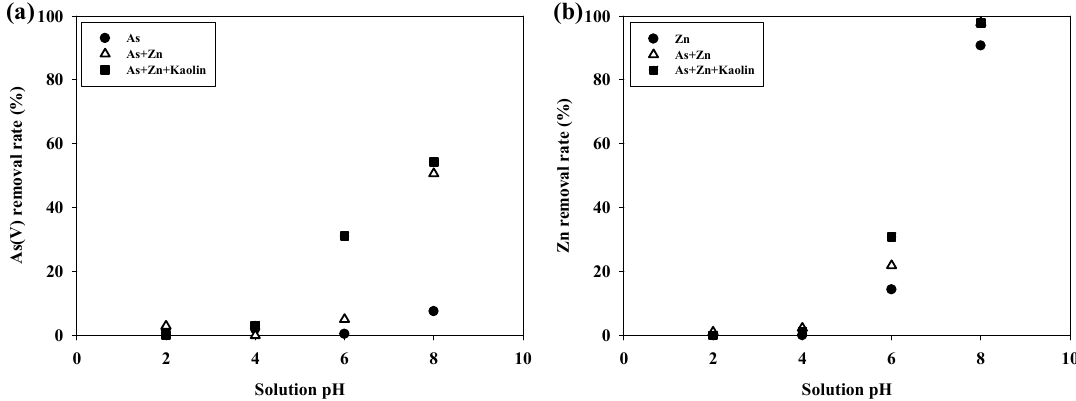
Figure 2. (a) As(V) and (b) Zn(II) removal according to solution pH using the ceramic membrane. Figure 2. ( a ) As(V) and ( b ) Zn(II) removal according to solution pH using the ceramic membrane.